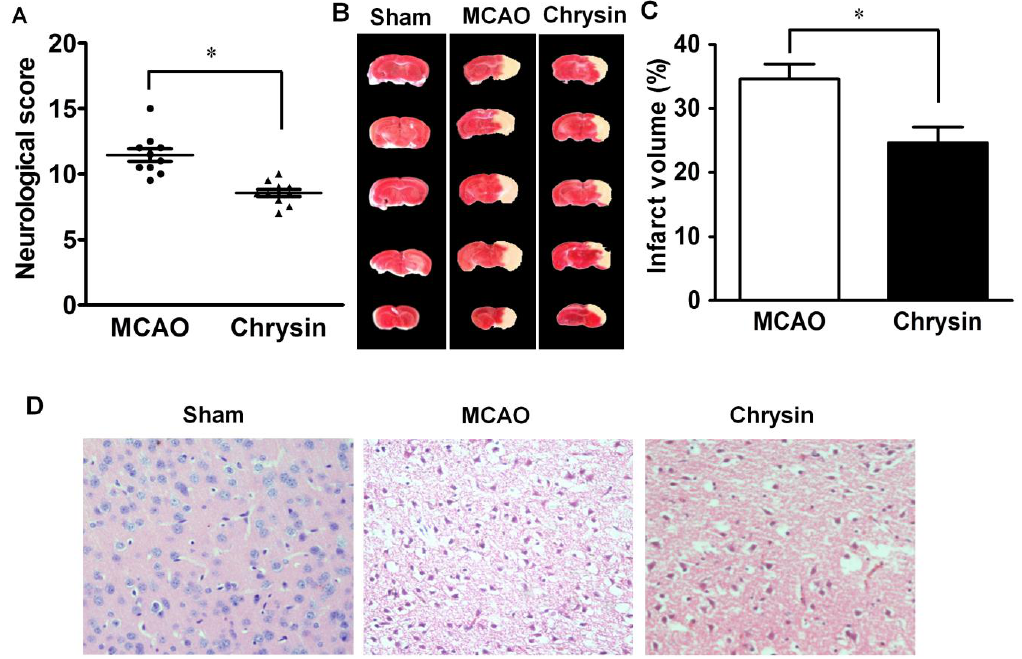
Figure 1. Effect of chrysin on neurological deficits, brain infarct volume and pathomorphological changes in mice with cerebral I/R injury. ( A ) Neurological score was measured in mice that underwent 1 h of ischemia followed by 24 h of reperfusion. Chrysin decreased the neurological score compared to the middle cerebral artery occlusion (MCAO) group; ( B ) Representative coronal brain sections stained with 1% TTC. Mice were subjected to 1 h of ischemia followed by 24 h of reperfusion; the infarct area is white; ( C ) Quantitative analysis of the percentage of brain infarct volume. Chrysin pretreatment diminished the percentage of brain infarct volume and there is a statistical difference compared with the MCAO group; ( D ) H&E staining showed that the normal morphologic features of neurons were present in the sham group. The MCAO group showed the loss of neurons and the presence of multiple vacuolated interspaces. Chrysin significantly ameliorated the damage of neurons that is associated with ischemia in the MCAO group (Magnified 20×). Data are expressed as means ± SEM, * p < 0.05, vs. MCAO group, n =